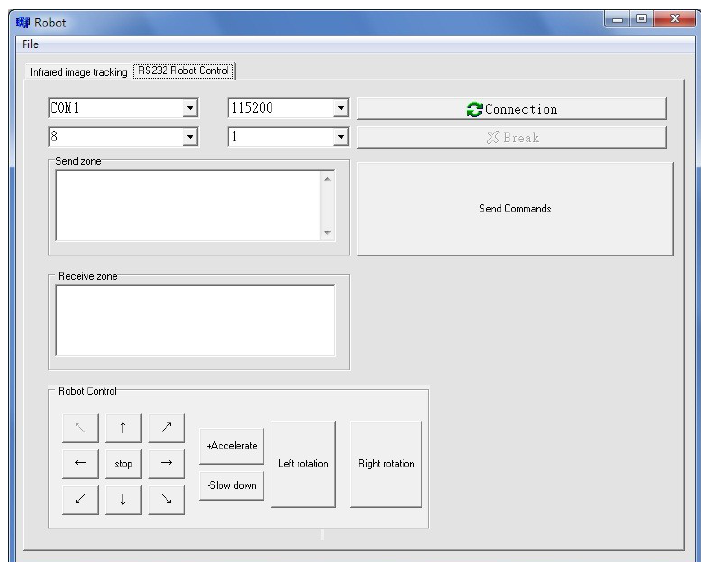
Figure 14. The data link control